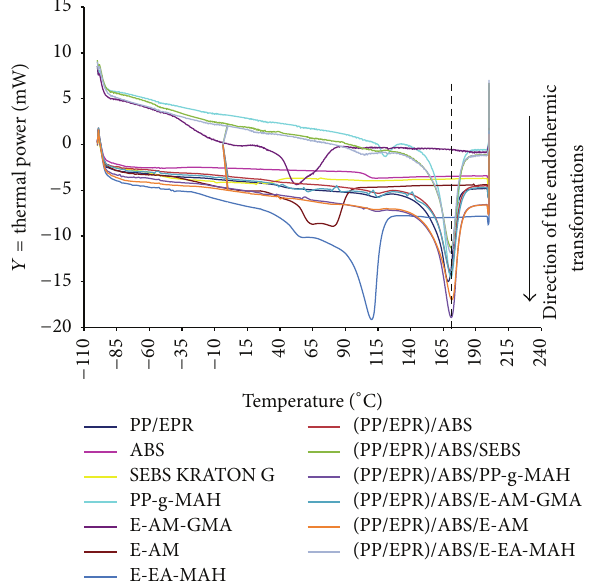
Figure 9: DSC curves in the direction of the endothermic transfor- mations of components and mixtures (PP/EPR)/ABS/compatibiliz- er (95)/5/5, for the first thermal cycle. For about 15mg of sample. 1 graduation 𝑌 = 5